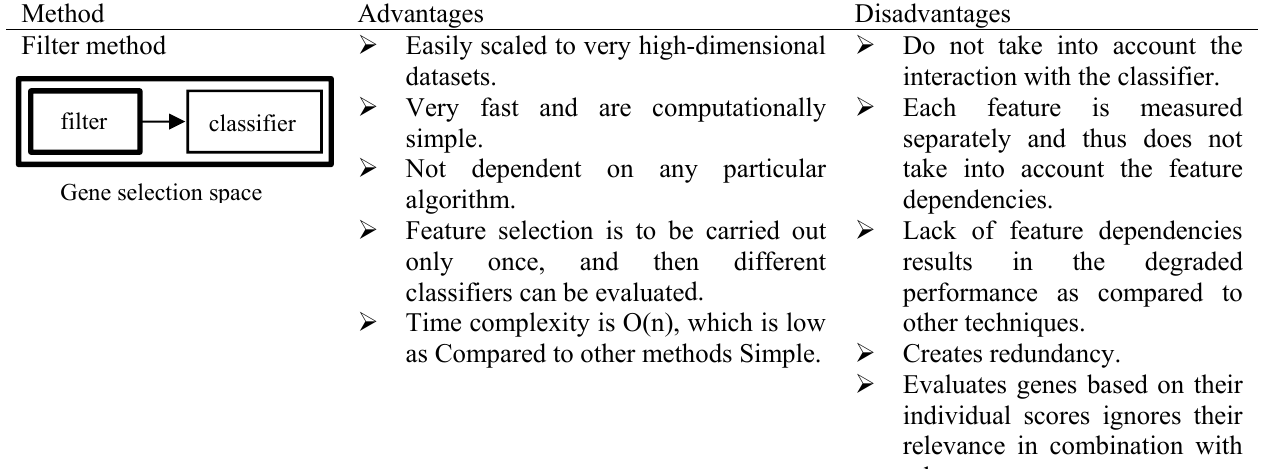
Table 1. Comparison of General Schemes for Gene Selection Methods